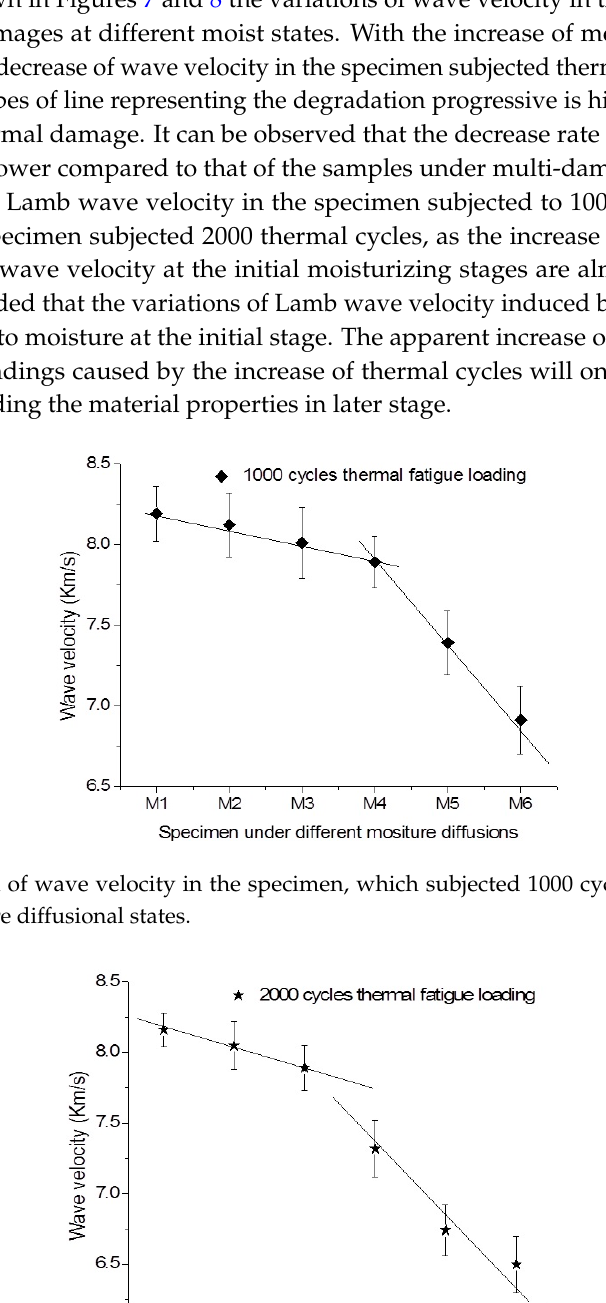
Figure 8. Variation of wave velocity in the specimen, which subjected 2000 cycles thermal fatigue, in different moisture diffusional states.